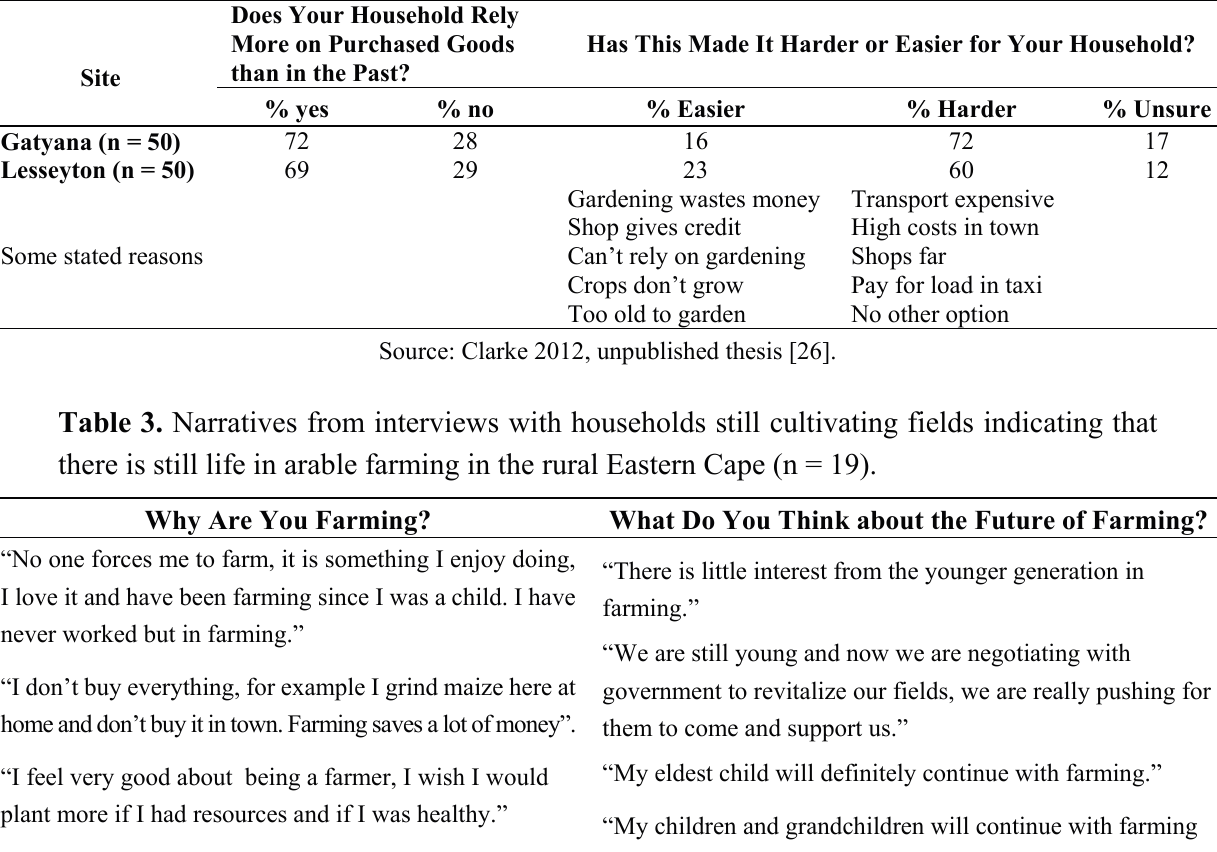
Table 2. Reliance on purchased rather than on collected natural resources and cultivated food amongst vulnerable households in Gatyana and Lesseyton and perceptions of the impacts of this reliance (n = 100).